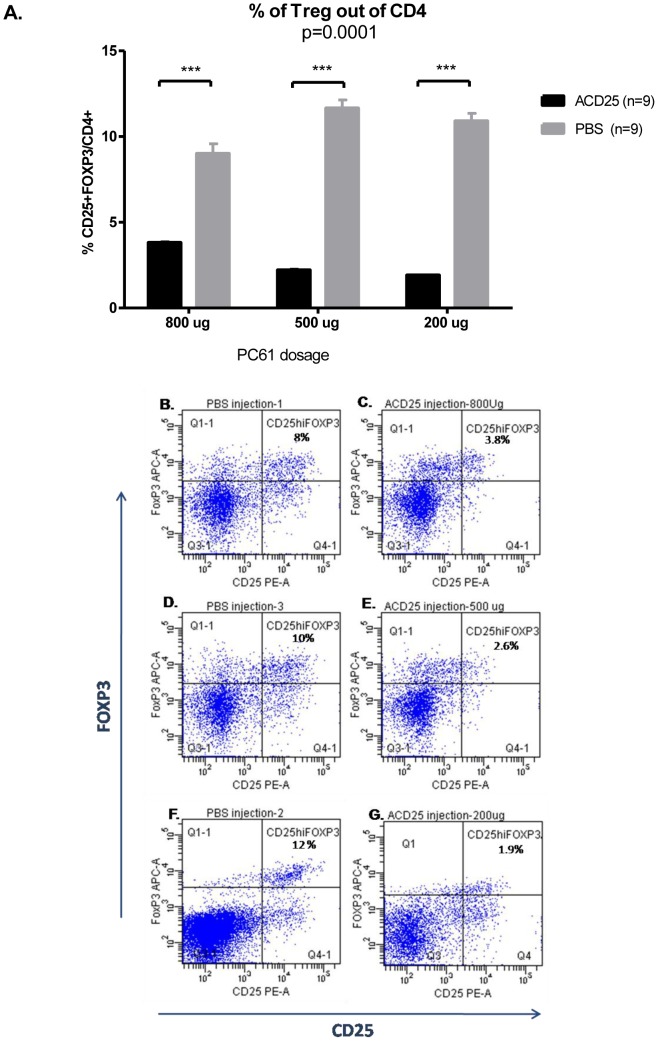
Anti-CD25 mAb (PC61) depletes CD4+CD25+FOXP3 cells.(A) The antibody dosage at three different ratios. Representative FACS picture shows the levels of CD25hiFOXP3 out of CD4+: (B), (D), (F) PBS injection group (C) ACD25 injection group: 800 µg (E) 500 µg and (G) 200 µg. p based on Two-way ANOVA; ***p<0.0001 based on Bonferoni's multiple comparison test.